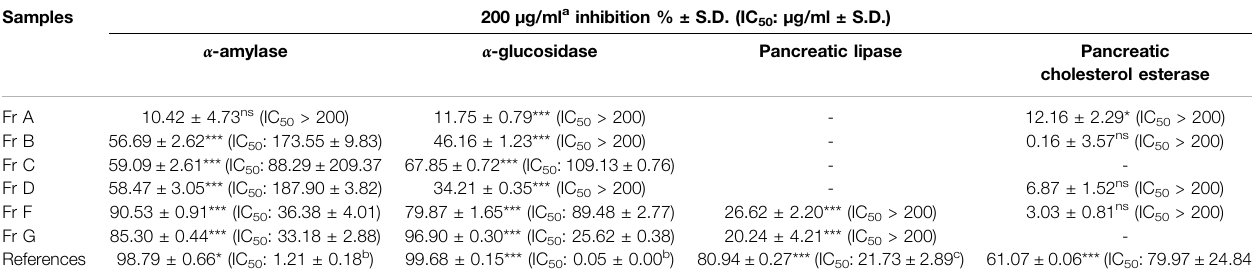
TABLE 3 | Enzyme inhibitory activity results of fractions from polyamide column chromatography of EtOAc sub-extract.